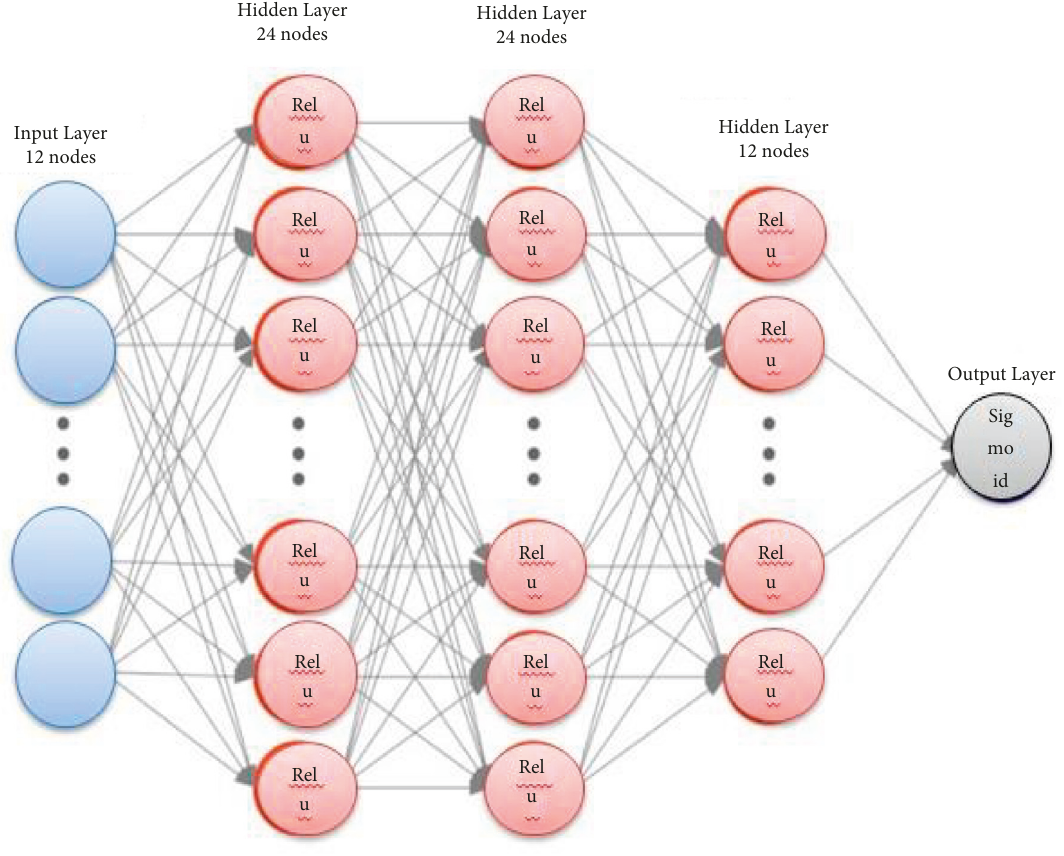
Figure 5: ANN model used for predictive